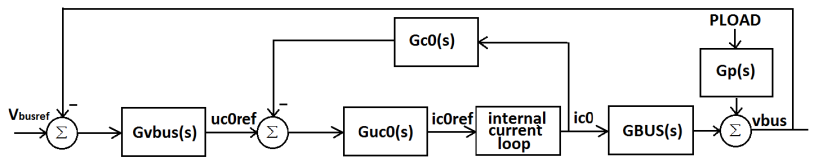
Figure 10. DC bus voltage